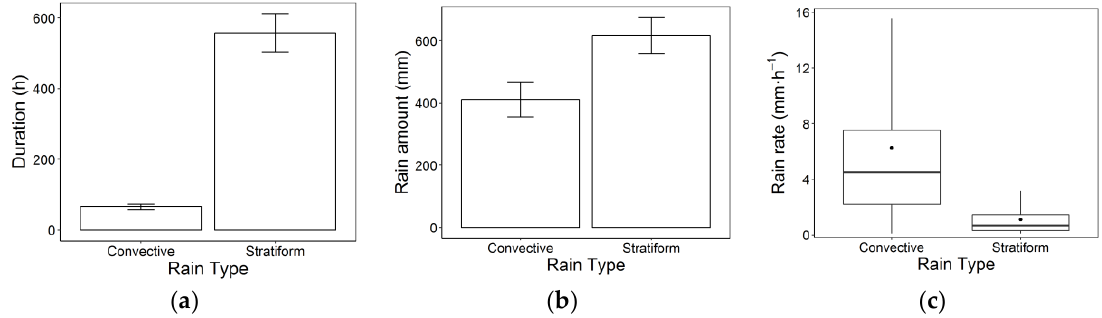
Figure 1. ( a ) A bar plot of accumulated rain duration in hours; ( b ) a bar plot of accumulated rain amount in mm; and ( c ) a boxplot of rain intensities in mm·h − 1 for each rain type at Lausanne, Switzerland (December 2008 – September 2010). Error bars in panels ( a ) and ( b ) are based on the standard error across devices. In panel ( c ) outliers are not shown, medians (means) are represented by the horizontal thick lines (black points), and the lower and upper hinges represent the first and third quartiles, while the upper (lower) whisker extends from the upper (lower) hinge to the largest (smallest) value no further than 1.5 times the interquartile range from the hinge [69].